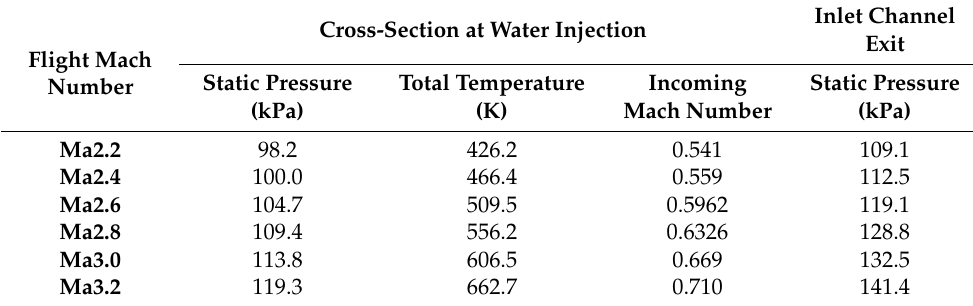
Table 1. Boundary condition for water injection simulations.